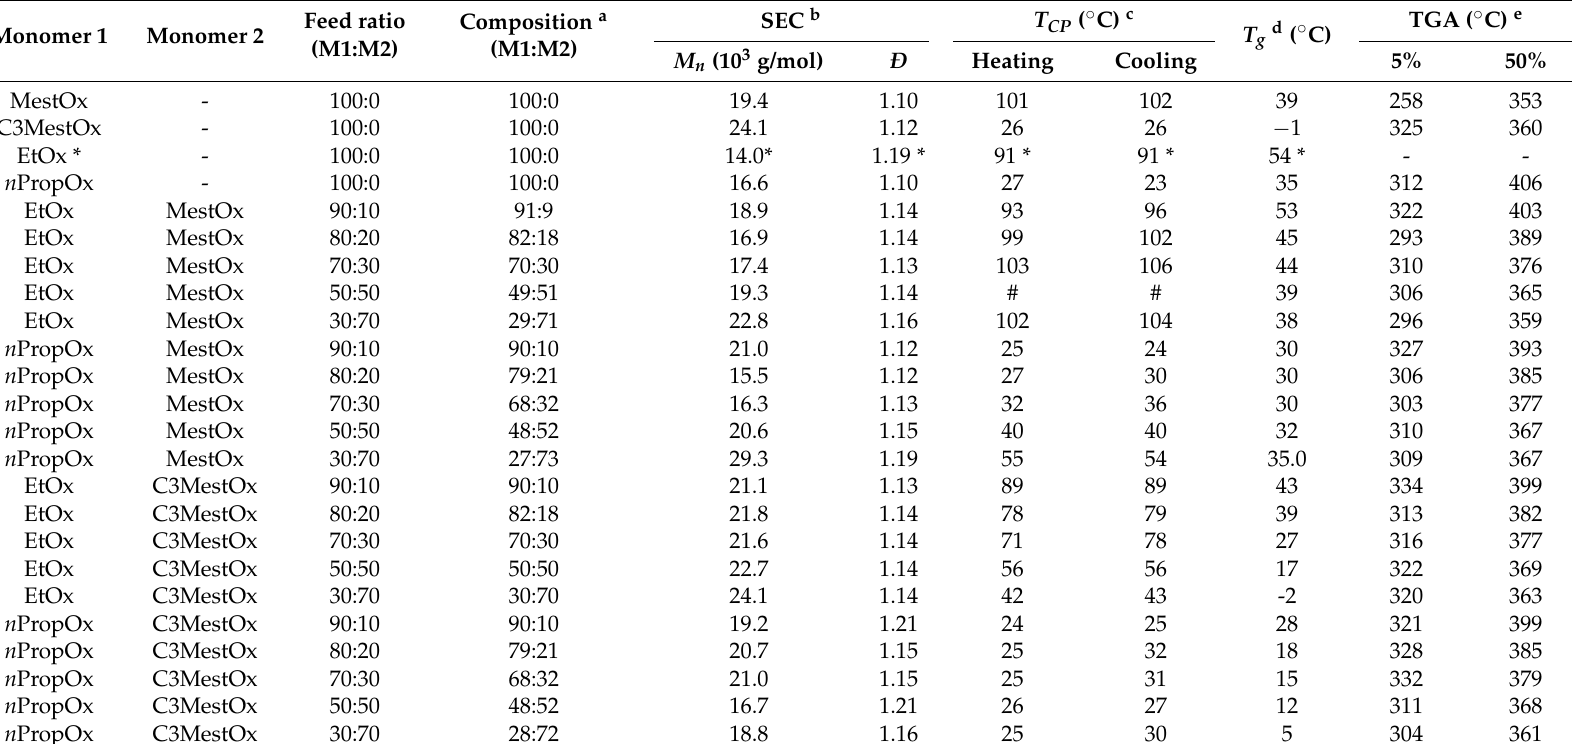
Table 1. Overview of synthesis and characterisation data of studied